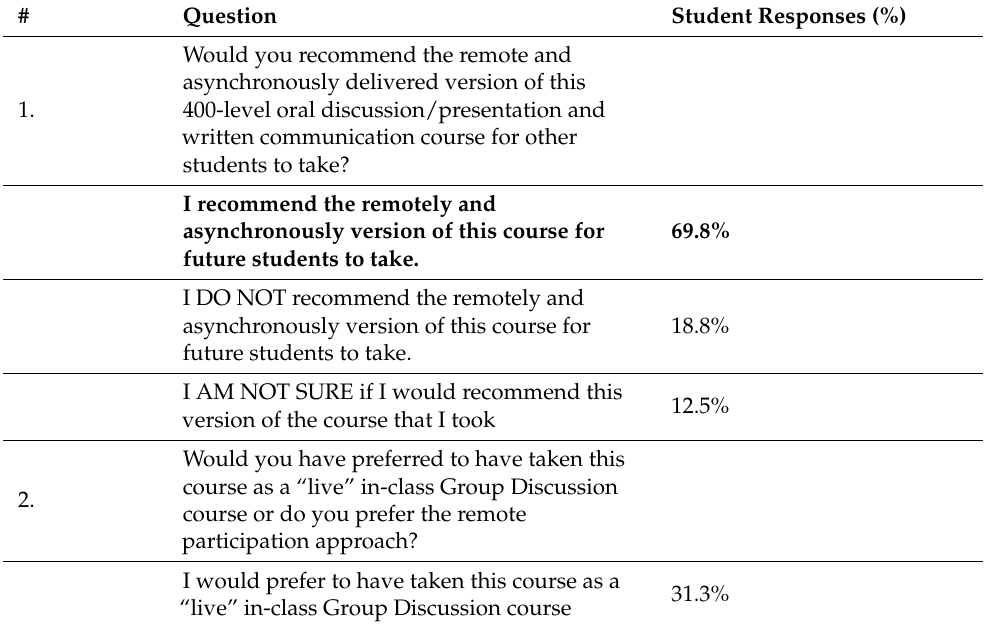
Table 2. Course evaluation feedback from enrolled students on 400-level, remote, asynchronous delivery of an oral discussion/presentation and written communication course (n =